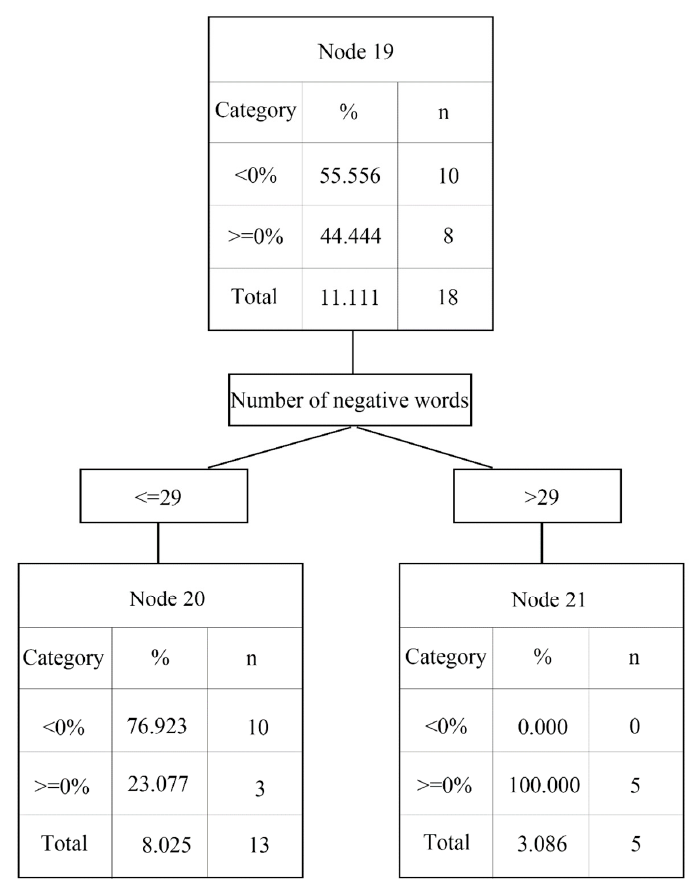
Figure 10. The classification results for N09 (Los Angeles Times) at Nodes 19–21.